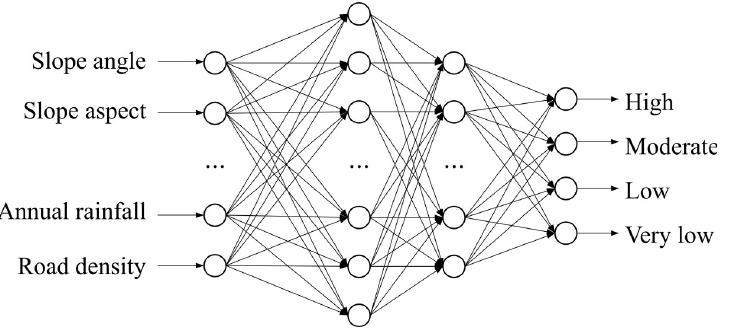
Fig 4. The structure of artificial neural network